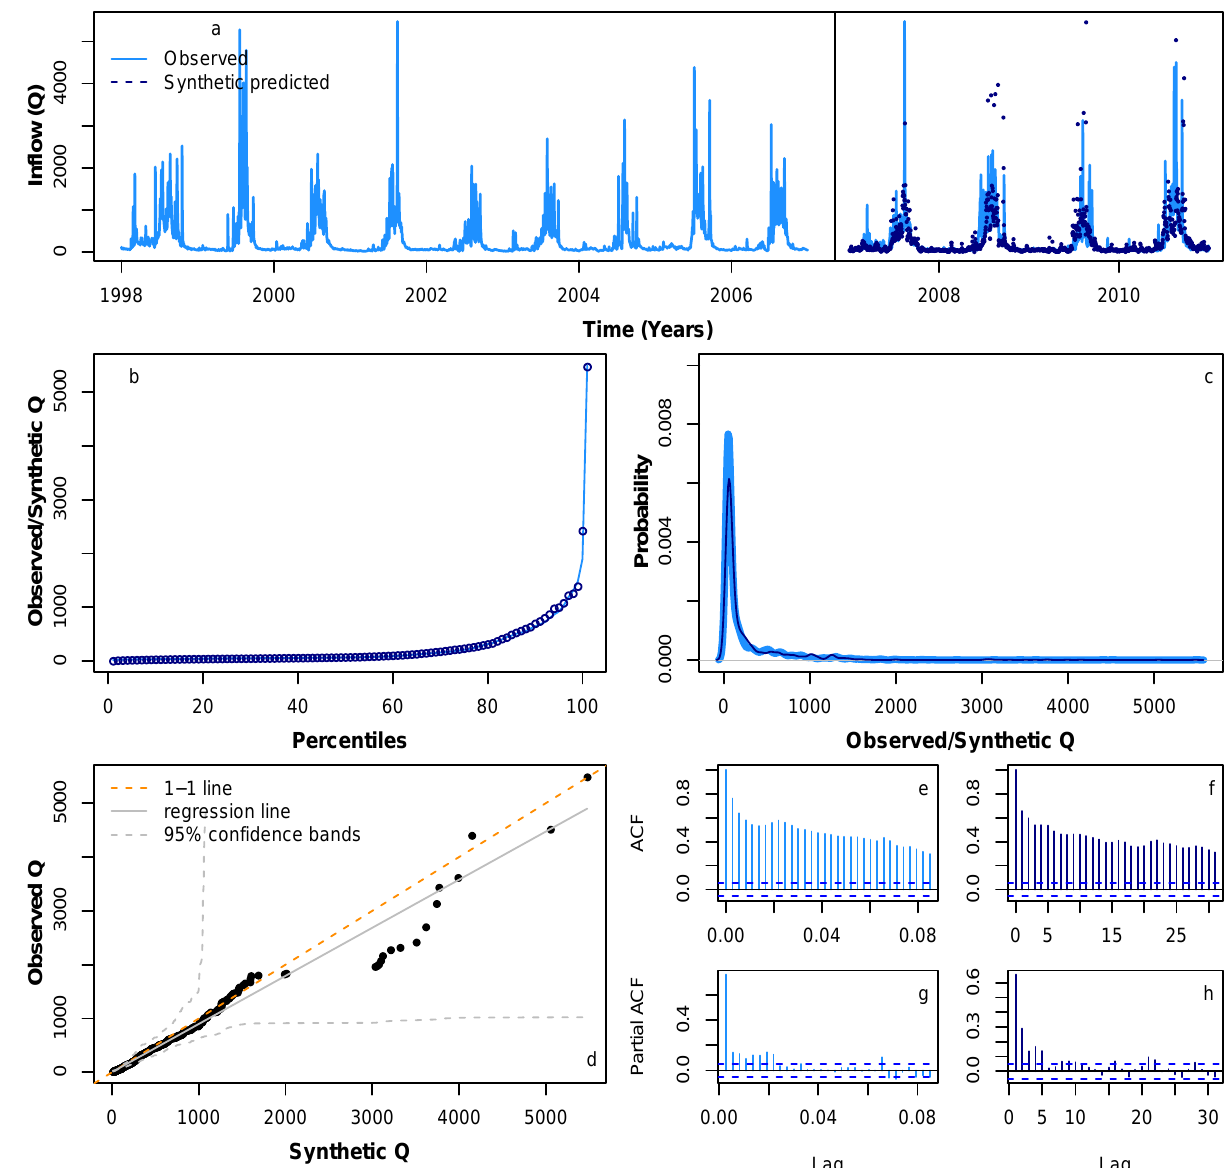
Figure 10. Comparison of various statistical characteristics of a sample predicted Q during the period 2007–2010 (dotted navy lines), based on learning inflow pattern from 1998 to 2006, with observed Q 2007–2010 time series (solid blue lines). Based on learning Q during the period 1998–2006, comparing ( a ) realisation of observed Q time series during the period 1998–2010 (solid blue lines) and a sample predicted time series during the period 2007–2010 (dotted navy lines); ( b ) percentiles for observed Q time series (solid blue lines) and a sample predicted time series during the period 2007–2010 (dotted navy lines); ( c ) probability density distribution for observed Q time series (solid blue lines) and a sample predicted time series during the period 2007–2010 (dotted navy lines); ( d ) QQ-plot for observed Q time series (solid blue lines) and a sample predicted time series during the period 2007–2010 (dotted navy lines); ( e ) ACF for observed Q 2007–2010 time series; ( f ) ACF for a sample predicted Q 2007–2010 time series; ( g ) PACF for observed Q 2007–2010 time series; and ( h ) PACF for a sample predicted Q 2007–2010 time